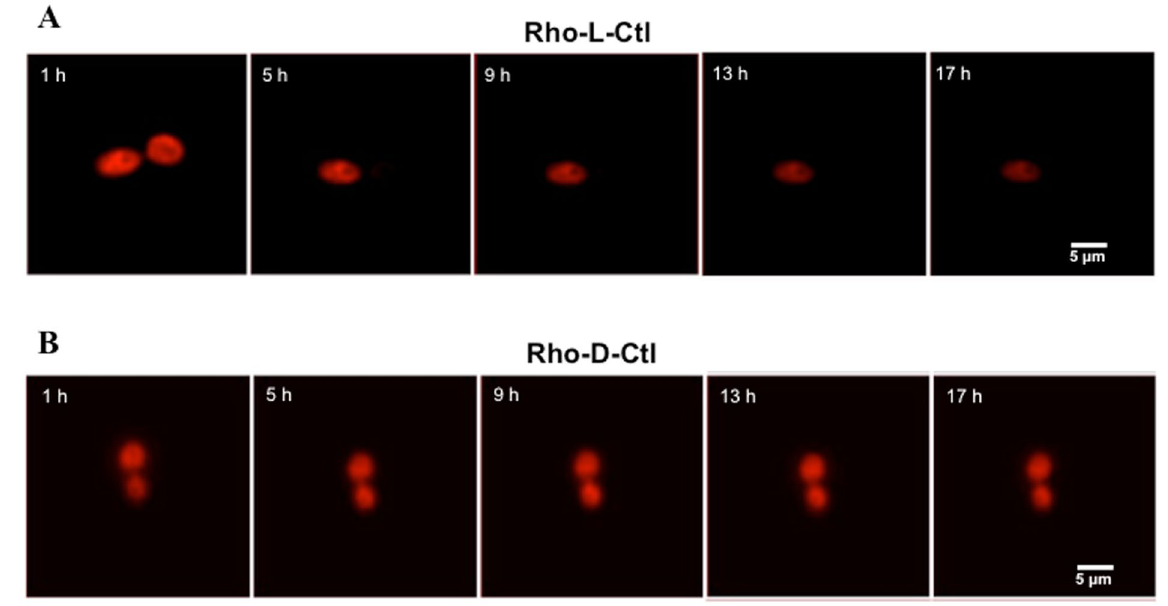
Figure 5. Comparison of the fluorescence intensity of Candida albicans treated with Rho-L-Ctl or Rho-D-Ctl. Candida albicans was incubated for 30 min at 37 °C with Rho-D-Ctl or Rho-L-Ctl at 10 × MIC (55 μ g/mL and 79 μ g/mL, respectively). Cells were then washed and the interaction between C. albicans and D-Ctl or L-Ctl was followed by video microscopy. Images were captured with a 60X objective. The time elapsed between two frames is 4